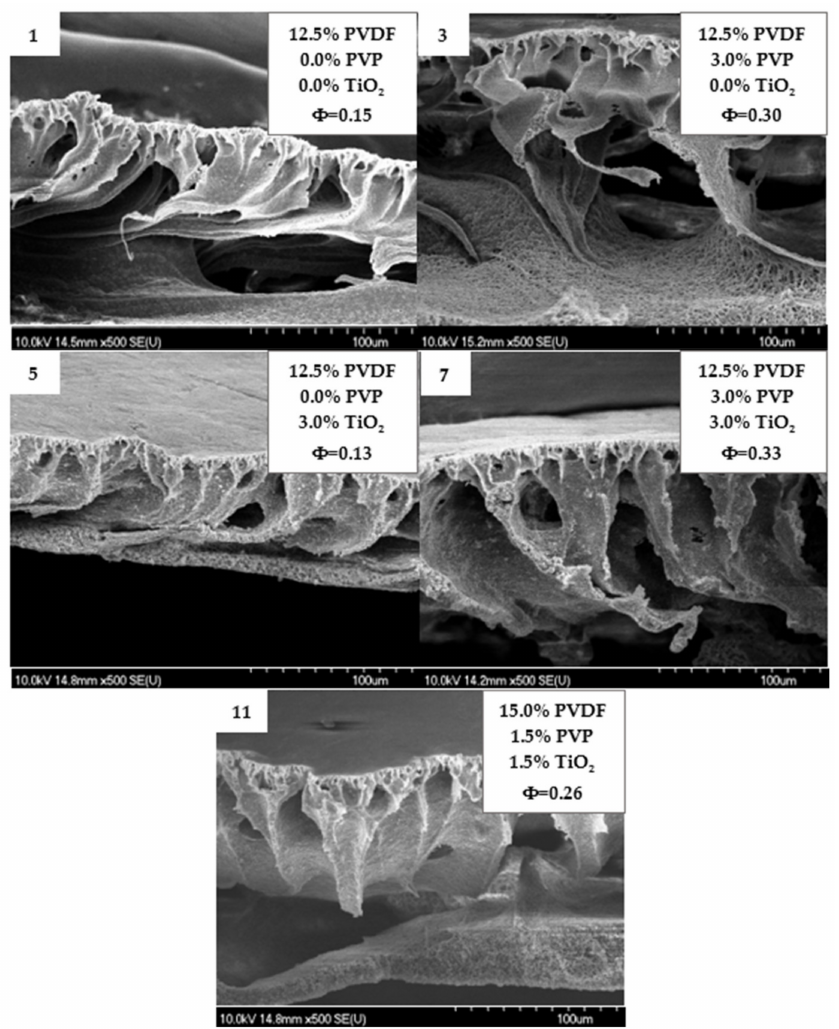
Figure 4. Scanning electron microscopy images of the cross-section of five different membranes containing PVDF, PVP and TiO 2 . Φ is the calculated average pore size in µ m.